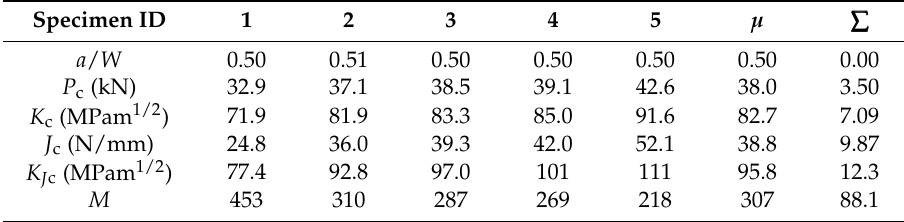
Table 5. Fracture toughness test results for case without CRS (S45C, SE(B) specimen, W = 46 mm, B / W = 0.5, − 10 °C). Here, μ and ∑ denote the mean and standard deviation of each parameter, respectively. Specimen